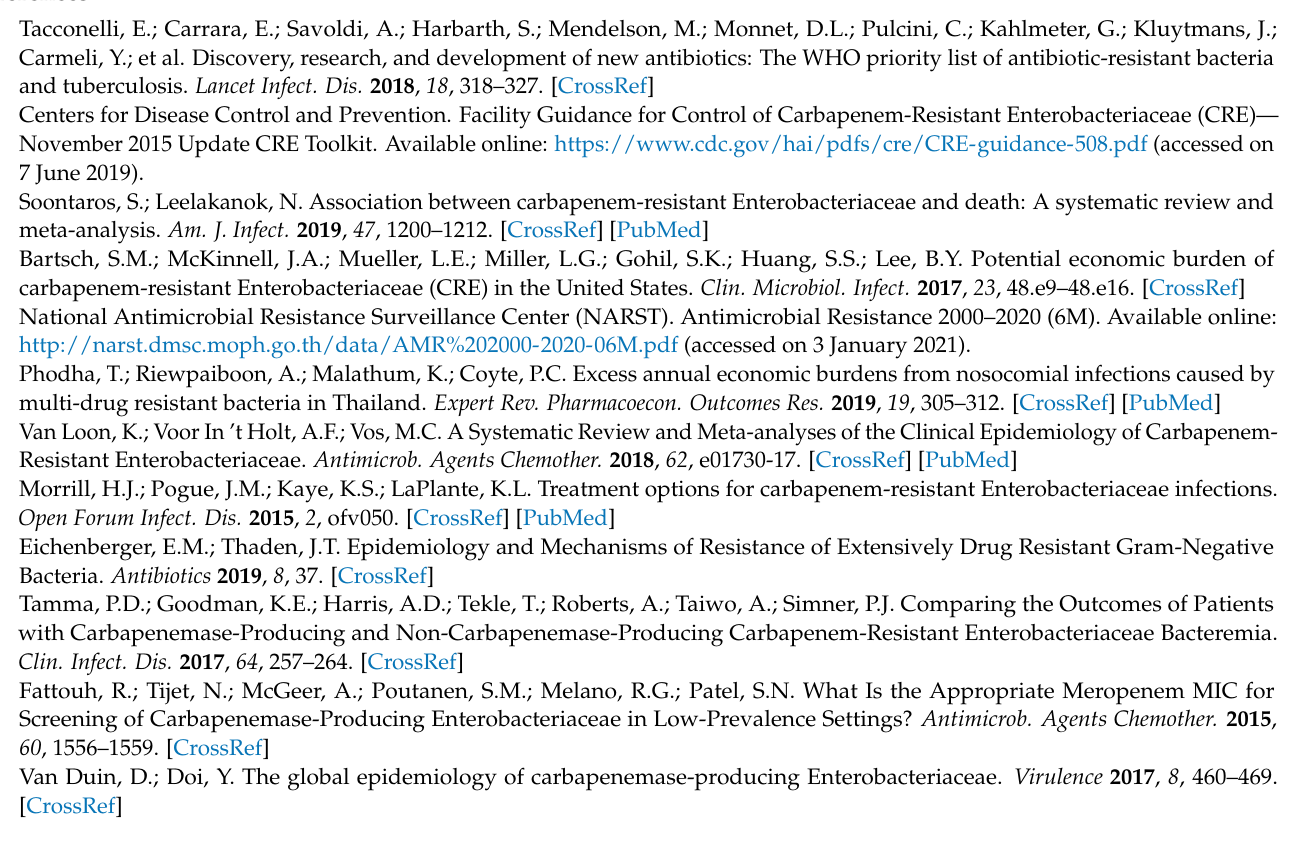
Table S2: Pharmacokinetic parameters of critically ill